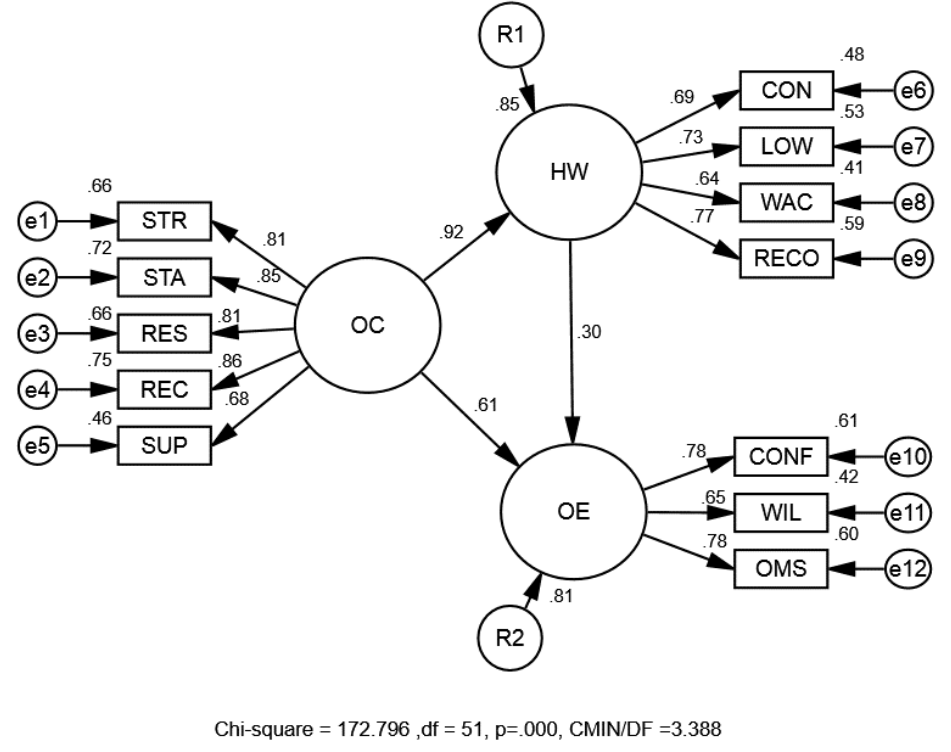
Figure 3. Model based on research